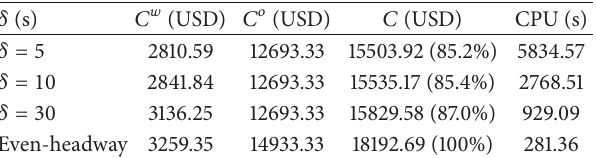
Table 4: Comparison between different optimal results.